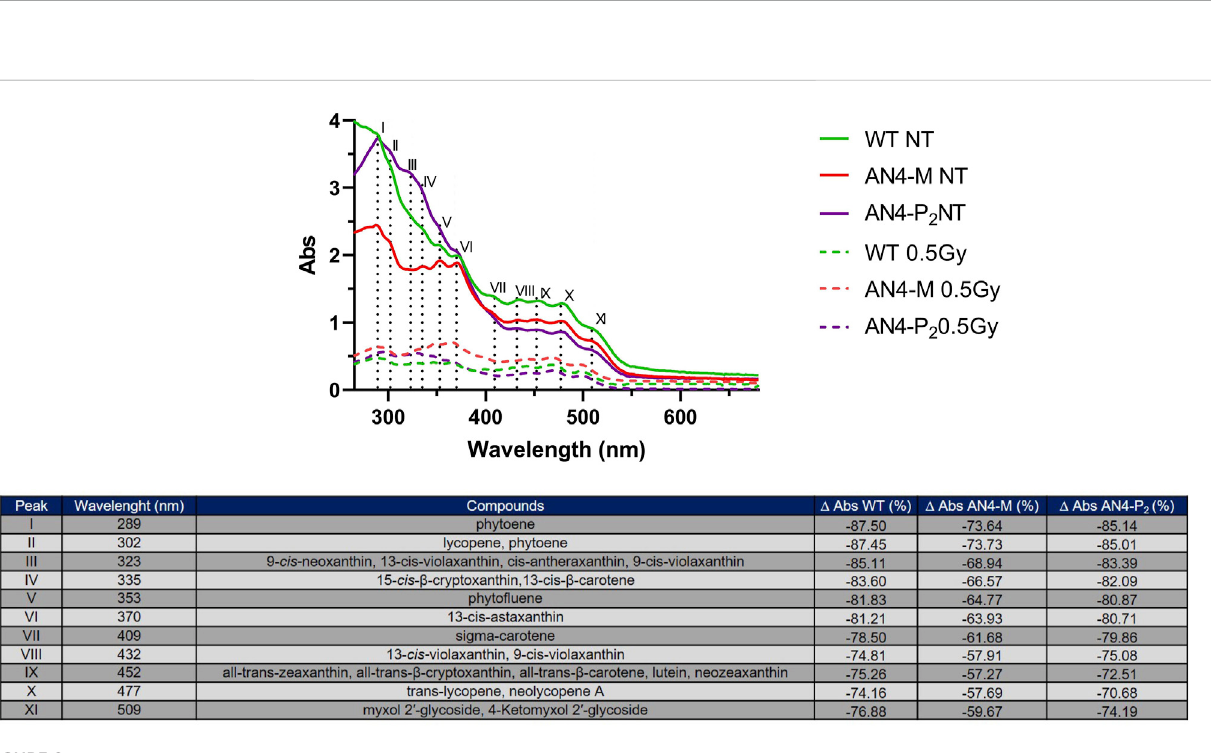
FIGURE 9 UV-VIS spectra of carotenoid extracts of ripe fruits before and after .5 kGy absorbed dose. The table reports the peaks and the corresponding compounds. The Δ Abs (%) was calculated considering the Abs after and before the irradiation for wild type, AN4-M and AN4-P 2 extracts.